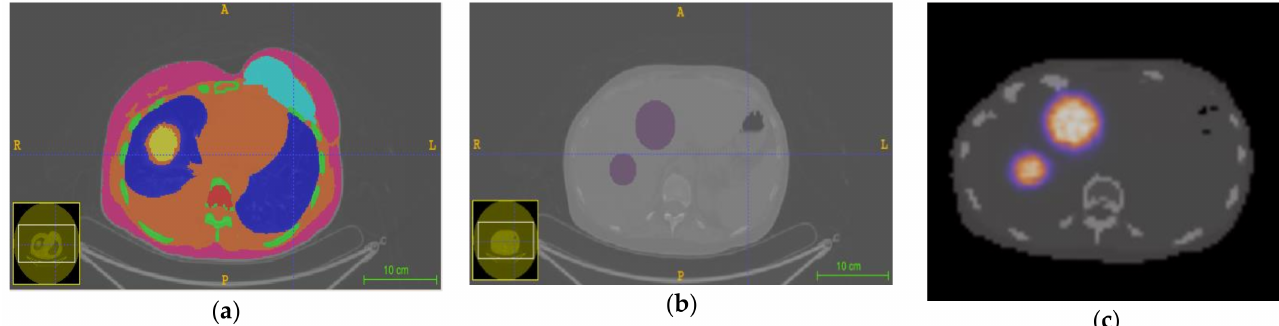
Figure 2. Three transversal slices of different images used in the SR case: ( a ) contoured CT (in this slice all the contoured regions are visible), ( b ) activity map and ( c ) SPECT superimposed on the coregistered CT. Activity is just in the spheres (MS and BS are visible in ( b , c ), while SS is located on another transversal